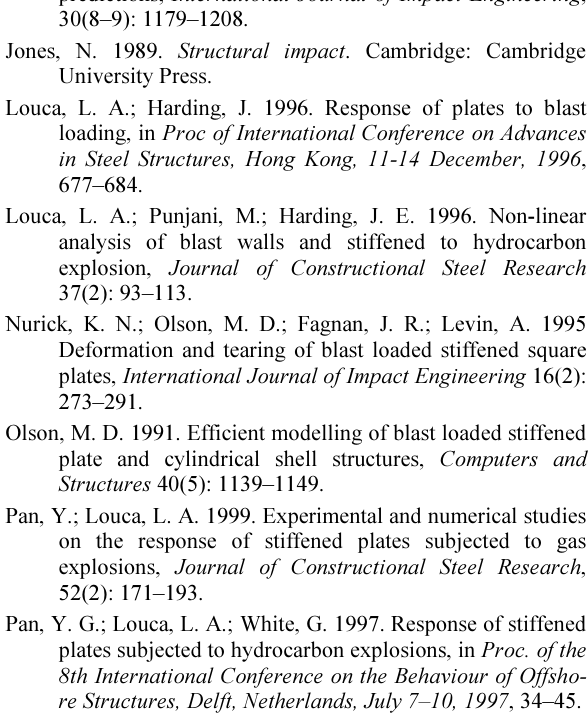
Fig. 13. History of plastic strain energy ( d